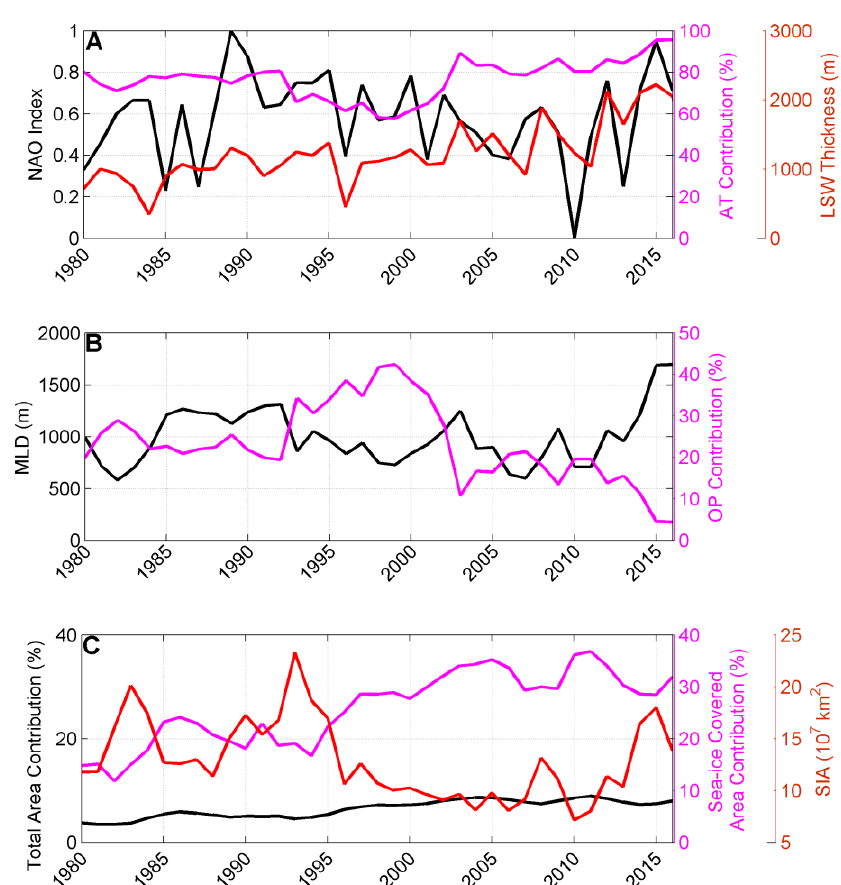
Figure 5. The relative contributions (%; magenta lines) of atmospheric forcing ( A ), oceanic preconditioning ( B ), and sea ice ( C ) to deep convection in the Labrador Sea. The red and black lines in ( A ) are LSW thickness (m) in the CTRL and the NAO index, respectively. The black line in ( B ) is the mixed layer depth (m). Additionally, the red line in ( C ) is the sea ice area that used in the ensemble members of EXP-SI; the solid black line in ( C ) is the sea ice contribution to deep convection in the Labrador Sea calculated over the whole region. The curve corresponds to the Y -axis of the same